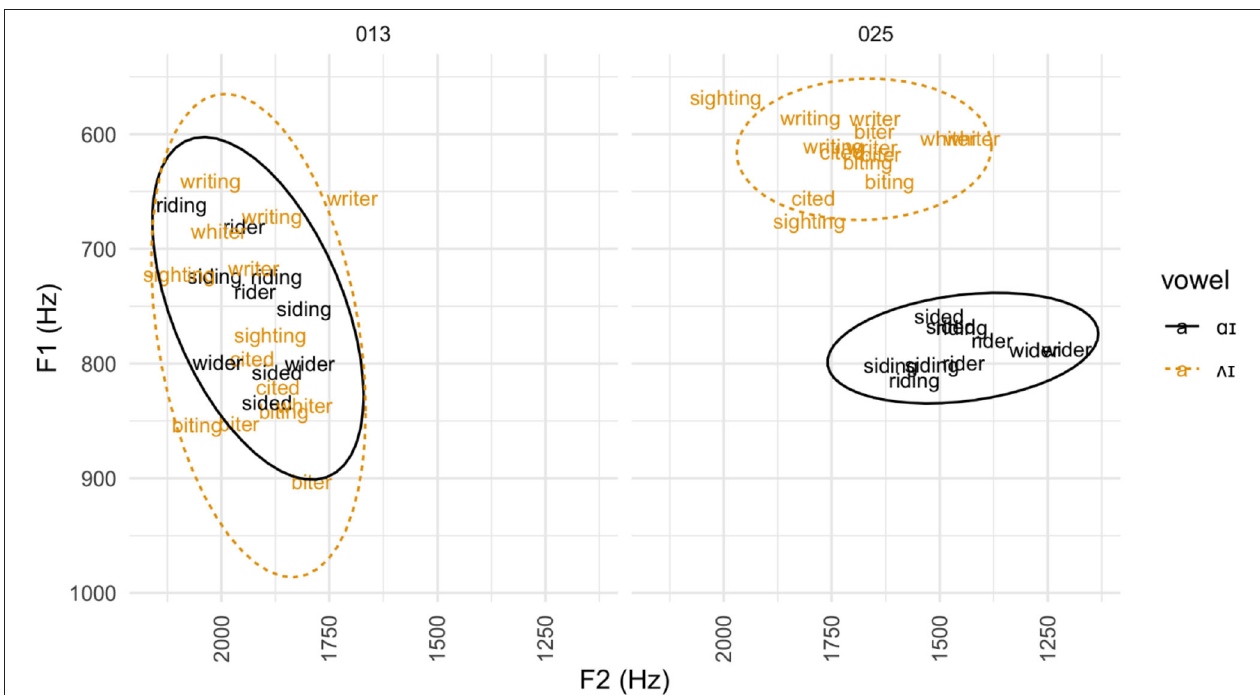
FIGURE 10 | Vowel plot for writer-rider productions with low vs. high Pillai scores. Individual tokens of words representative of the writer-rider contrast for Participant 013 (lowest Pillai score) and Participant 025 (highest Pillai score). Ovals indicate 95% confidence intervals for each vowel.